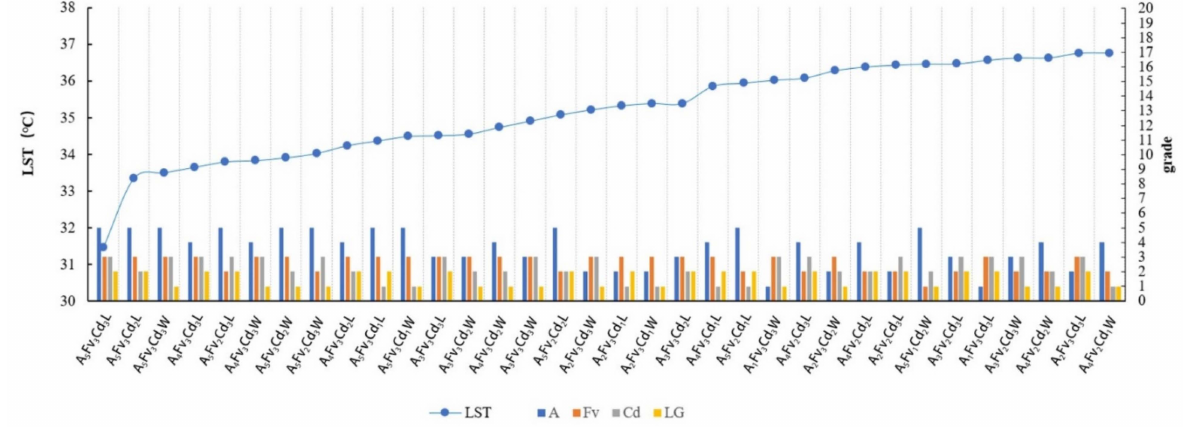
Figure 20. Sorted MG types with LST values lower than the 36.8 ◦ C Width-IV river buffer zone and the linear correlation between the MG types and their LST